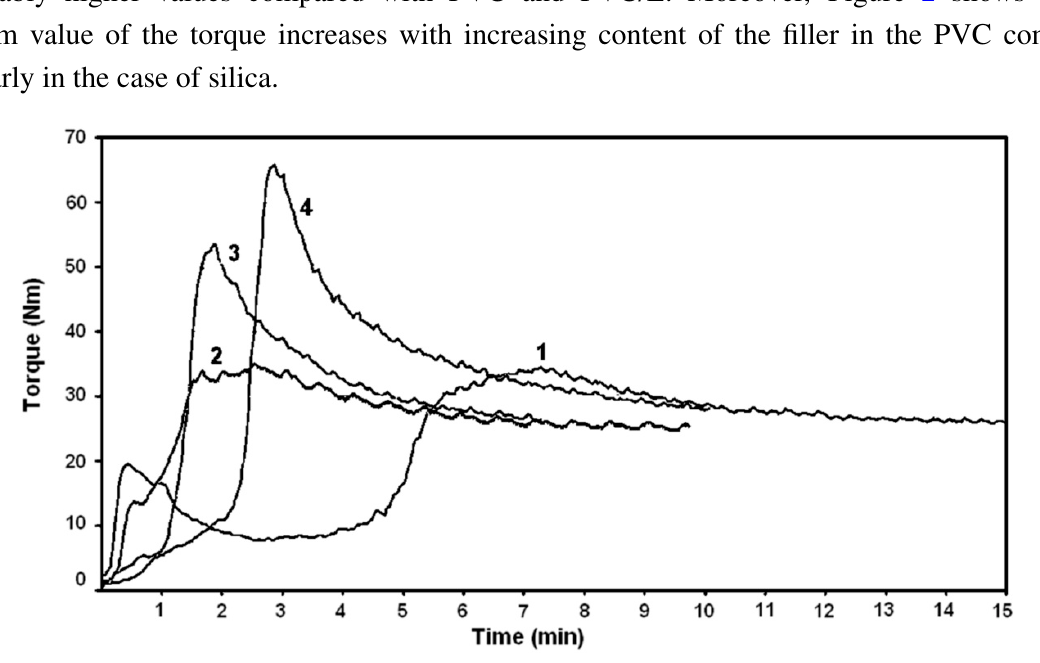
Figure 1. Torque vs. time of kneading for: 1, PVC, and PVC composites; 2, PVC/L; 3, PVC/H; 4, PVC/S.